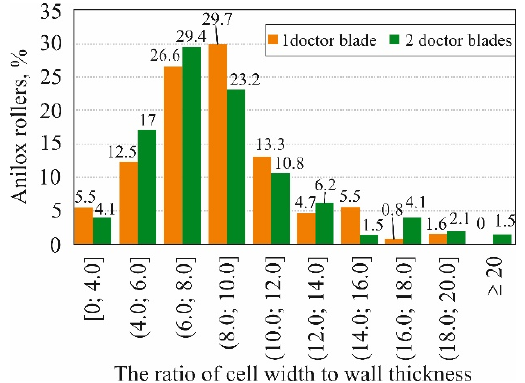
Figure 12. Distribution of anilox rollers according to the ratio of cell width to wall thickness and number of cells. Table 1. Statistics on the ratio of cell width to wall thickness of anilox rollers, grouped by the number of doctor blades.